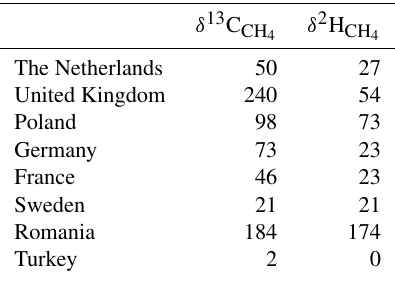
Table 3. Number of CH 4 isotopic source signatures derived from sample measurements in the